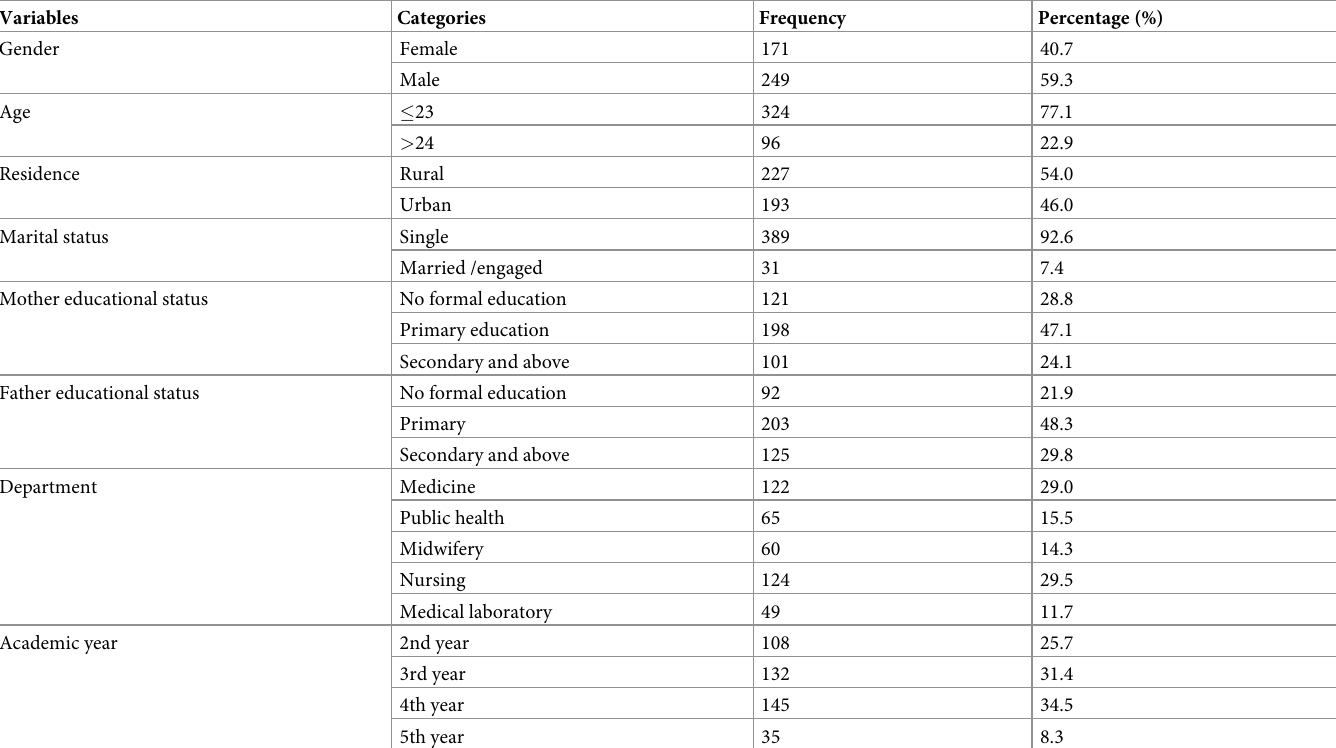
Table 1. Socio-demographic characteristics of medical and health science students attending Wolkite University, Ethiopia, 2021 (n =